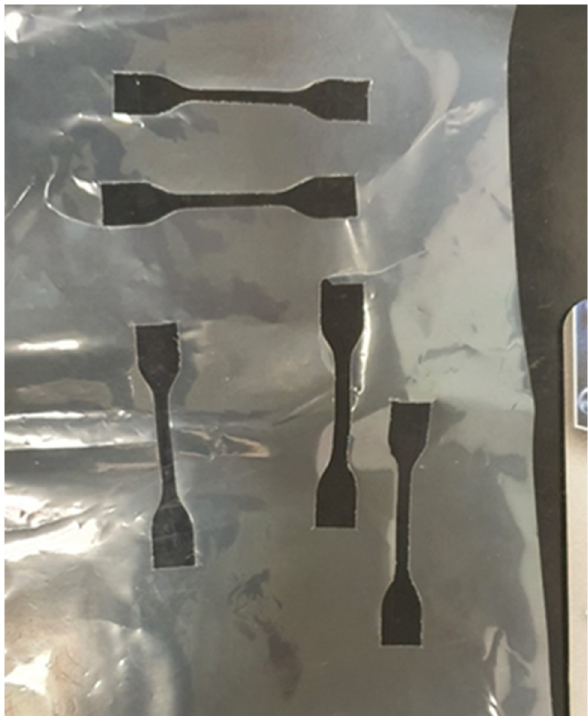
Figure 4. Cutting on B (Corn starch, cassava, and eucalyptus) biopolymer film to evaluate the mechanical properties with respect to the lamination direction.